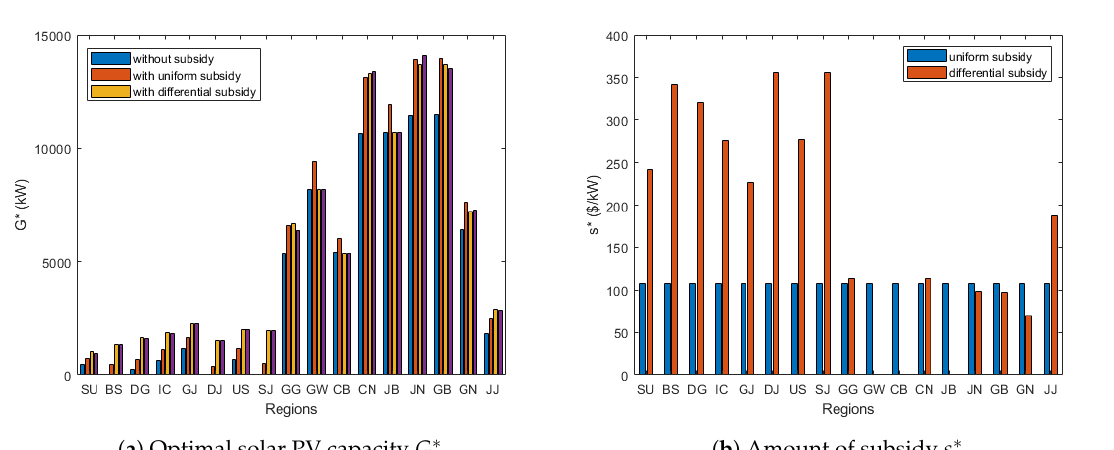
Figure 4. Solar PV capacity and subsidy results under different subsidy